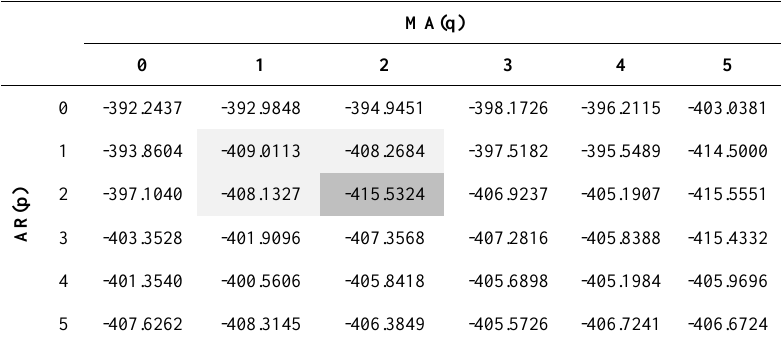
Table 2. Akaike Information Criterion (AIC) arrangement